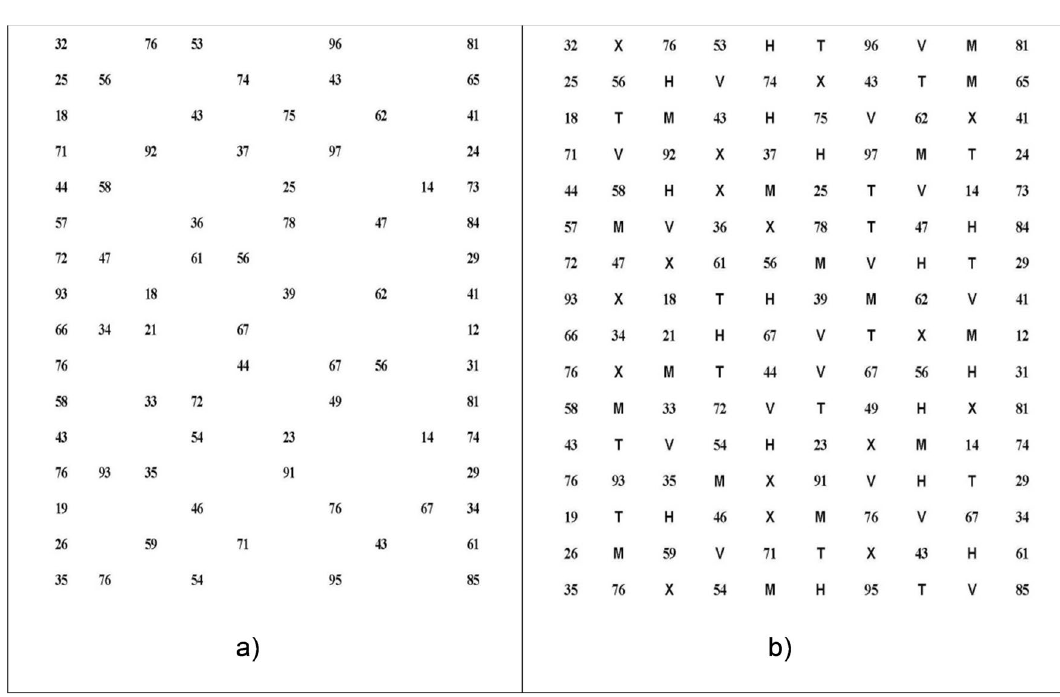
Figure 5. Vertical sheets (V1 and V2) of the ADEMd test.